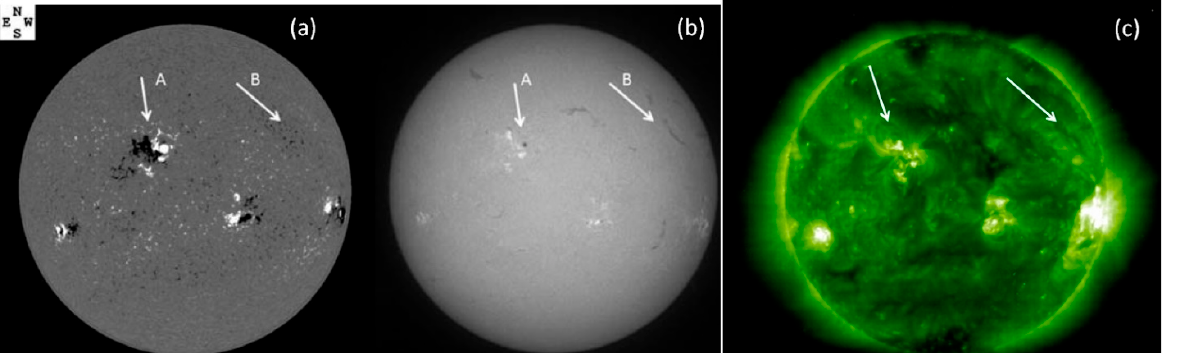
Figure 5. A photospheric magnetogram from the Big Bear Solar Observatory ( a ), chromospheric (H-alpha) image from the Kanzelhöhe Observatory ( b ), and a coronal (EUV) image from SOHO/EIT ( c ), all obtained on 2005 May 13. A large active region (A) and a filament region (B) are marked by arrows. In ( a ), black and white correspond to negative and positive magnetic polarity, respectively. In region A, the H-alpha image shows a sunspot, a reverse-S shaped dark filament, and bright plages, while in the region B the image shows just a dark filament. In the EUV images, active regions are bright compact features. Even the filament region shows surrounding faint loop arcade. The dark features in the EUV image are coronal holes.